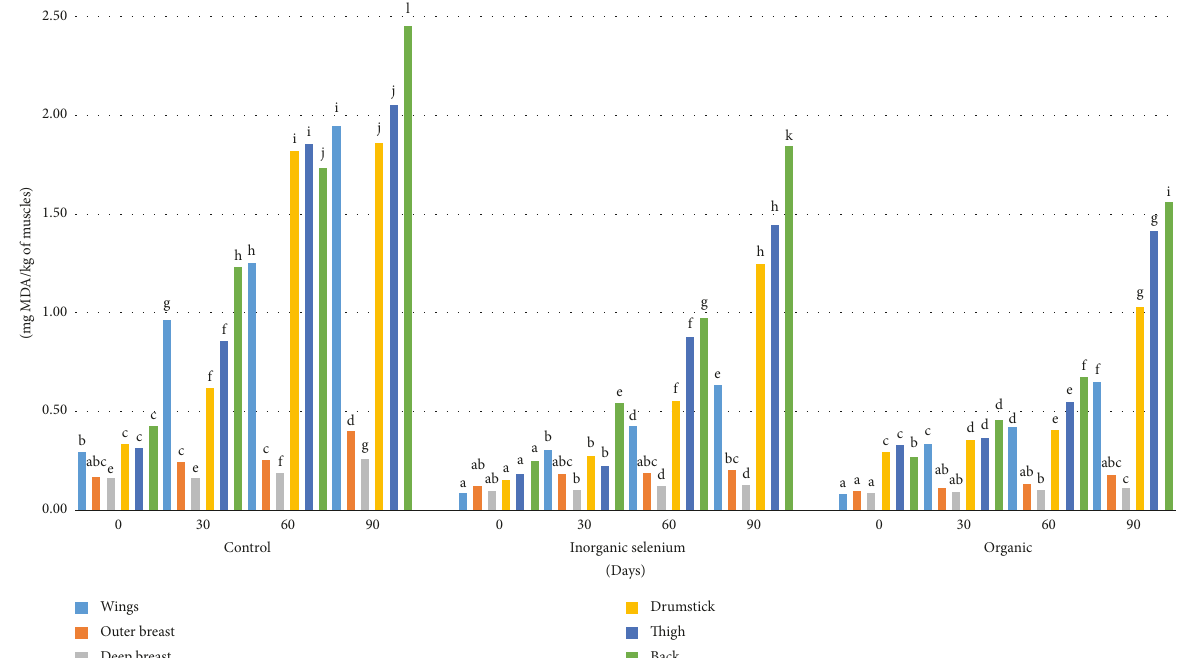
Figure 2: Changes in the thiobarbituric acid reactive substances during frozen storage of the culinary parts of chicken supplemented with